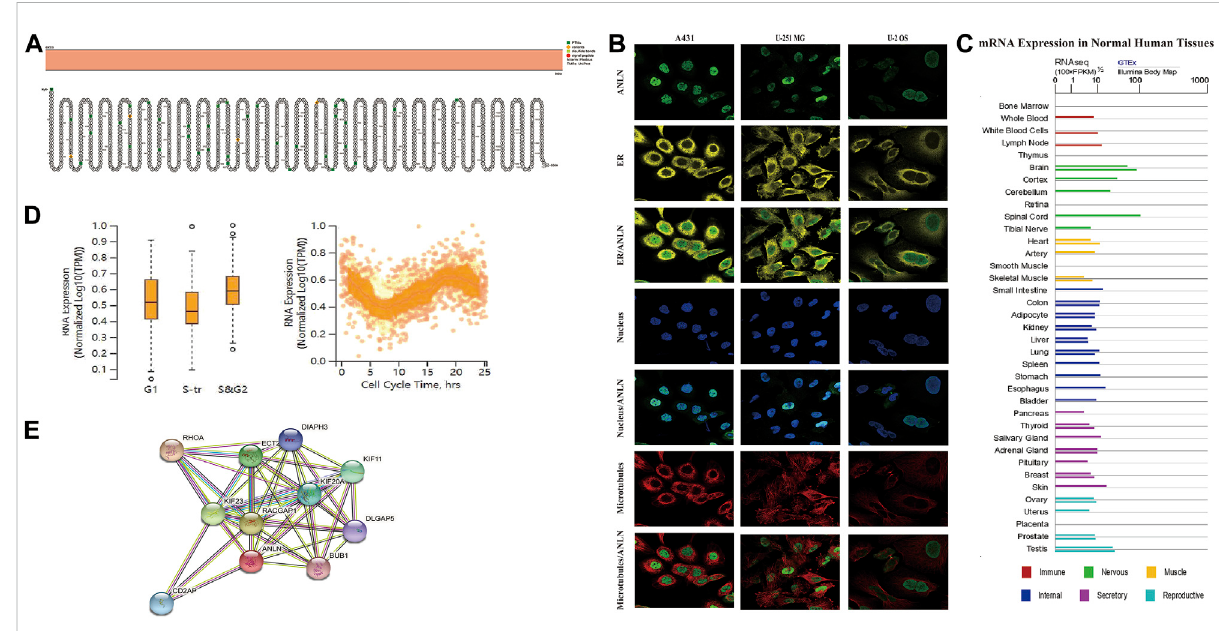
FIGURE 2 Topology, localization, expression pro fi le, and protein interaction network of ANLN proteins. (A) Topology of ANLN proteins showing intracellularmembranelocalization. (B) Immuno fl uorescencestainingofthesubcellulardistributionofANLNinthenucleus,endoplasmicreticulum, andmicrotubules ofA-431,U-2OS,andU-251MGwasadoptedfromtheHPAdatabase. (C) BargraphsofANLNmRNAexpressioninvariousnormal human tissues from the TCGA_GTEx database. (D) The plot of single-cell RNA sequencing data from the U-2 OS cell line shows a correlation between ANLN mRNA expression and cell cycle progression. (E) Protein interactions network of